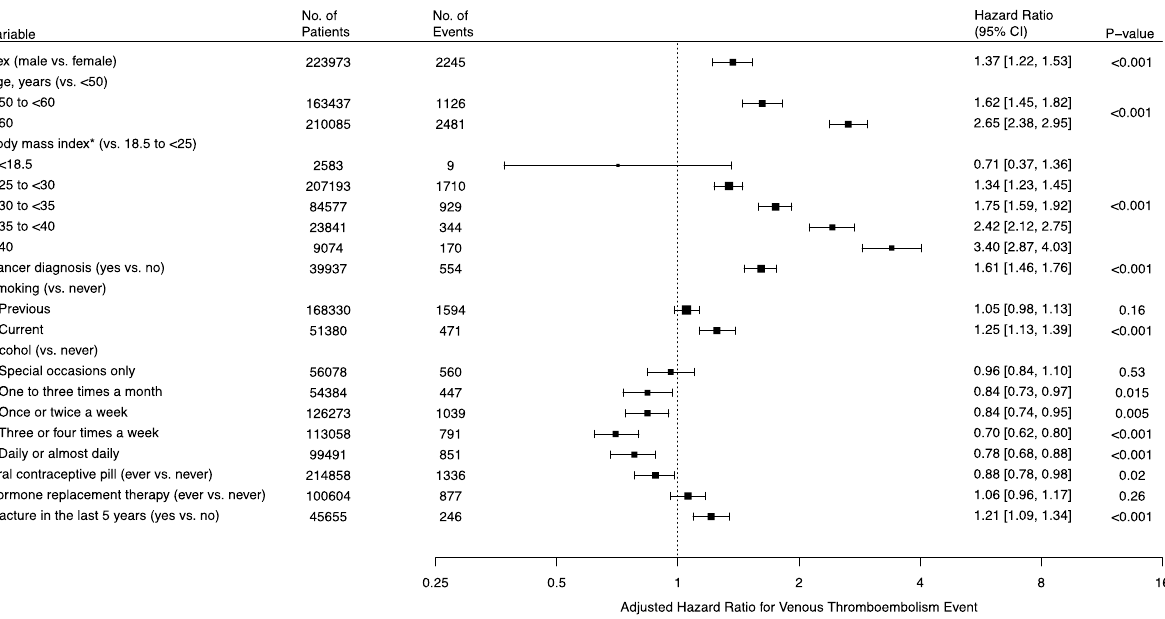
Figure 1. Adjusted hazard ratios for primary venous thromboembolism for established risk factors. Shown are the adjusted hazard ratios for primary venous thromboembolism for nine established risk factors. For any individual risk factor, models were adjusted for all other established risk factors and the first four principal components of ancestry. The I bars represent 95% confidence intervals. Body mass index (*) was measured in kg/m 2